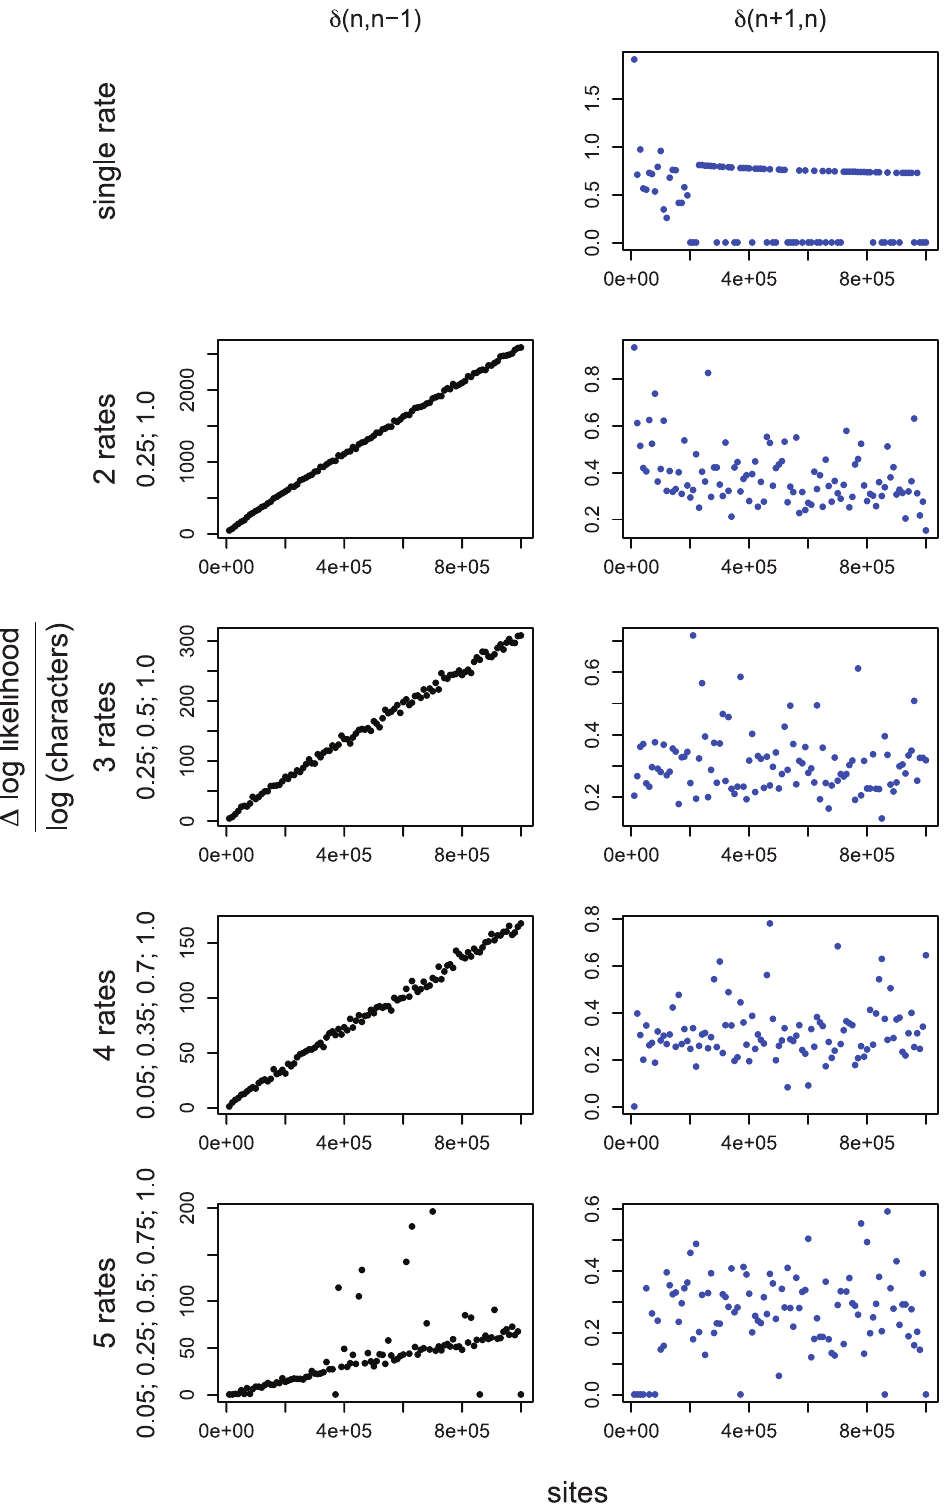
Figure 1. Simulation studies used to derive the appropriate penalty term for mBIC . Each panel plots the difference in log likelihood ( log L ) normalized by the logarithm of the sample size (number of characters), between best fitting GA models with n and k rates ( d ( n , k ) ), against the number of sites in the alignment. For simulations with a single rate class we plotted d (2, 1) , top right. Figures for multiple rate simulations (2–5 rates) show d ( n , n { 1) as black dots (left column); and d ( n z 1, n ) as blue dots (right column). Values to the right of row report simulated rates for each class. The left column is a reflection of power, whereas the right column – of the degree of over-fitting. For the case where a single rate was simulated, the degree of over-fitting is the rate of false positives. The desired behavior for mBIC is achieved when the model with n rate classes is preferred to